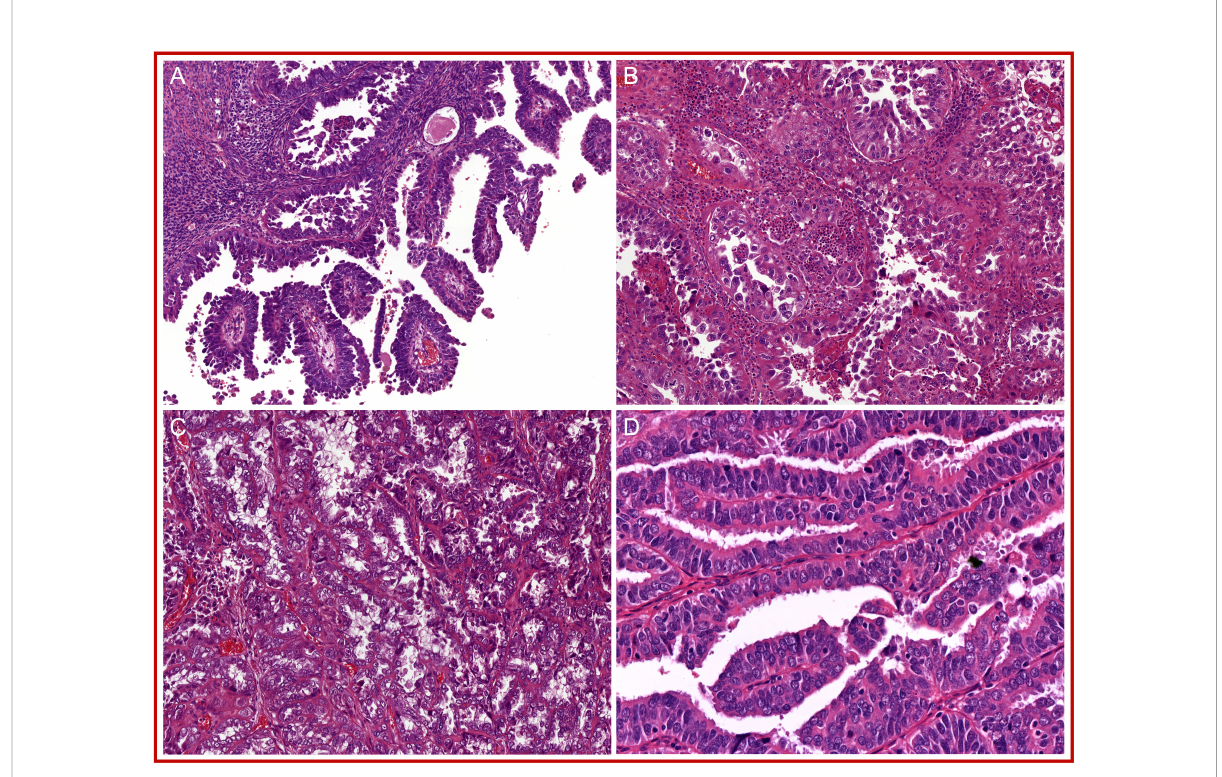
FIGURE 5 A selection of prototypical morphological features found in p53 abnormal endometrial cancer (p53abn EC): (A) (micro-)papillary glandular architecture; (B) glands with ragged luminal surface; (C) brisk mitotic activity; and (D) strong nuclear